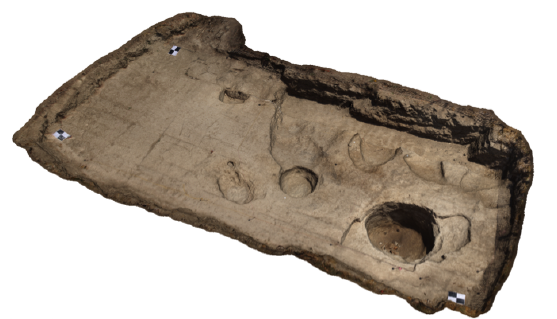
Figure 7: The 3d representation of the area recorded during the excava- tion session in 2015. Note some of the GCP, placed for the orientation of the